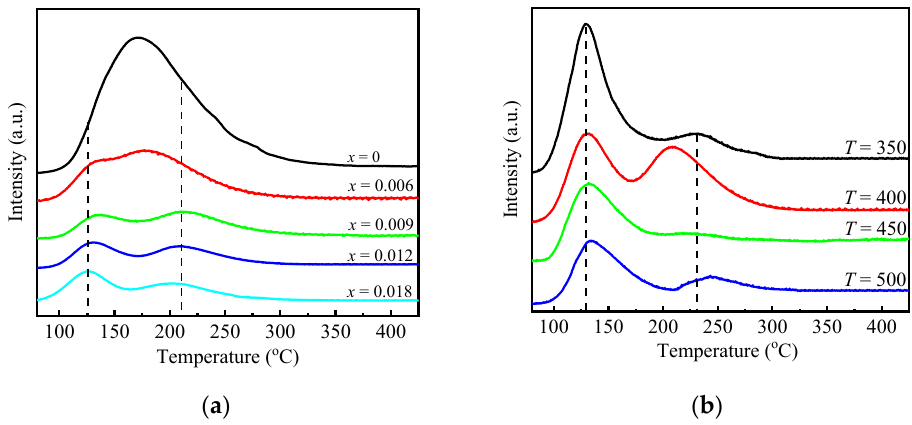
Figure 5. CO 2 -TPD patterns of ( a ) AlP 1.1 Zr x -400 and ( b ) AlP 1.1 Zr 0.012 - T samples.